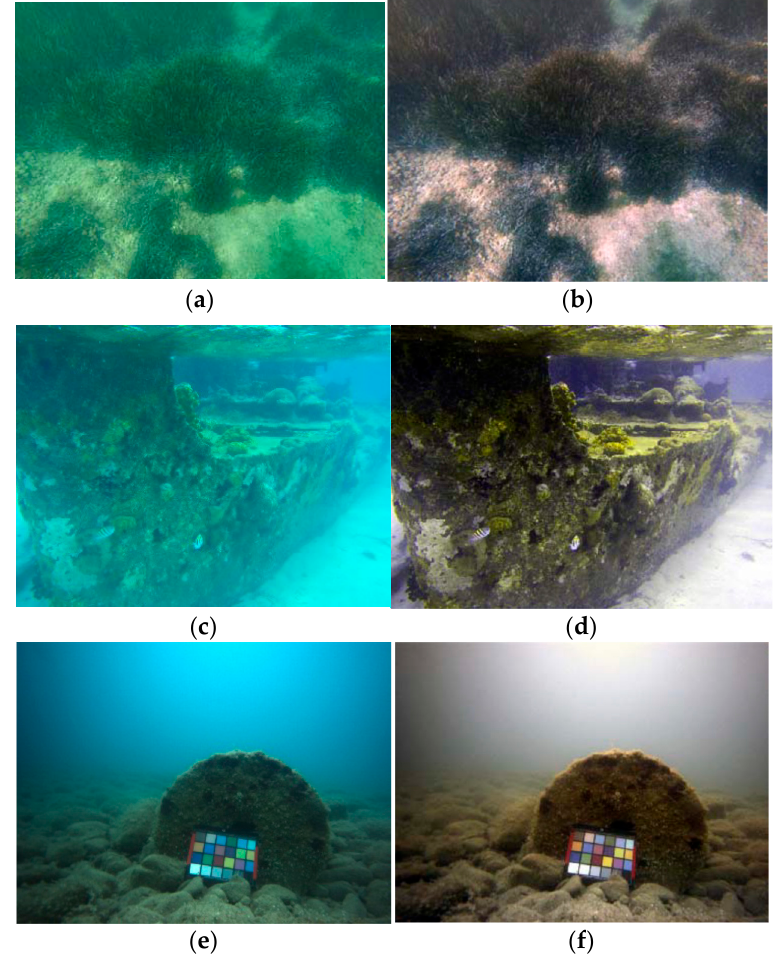
Figure 2. Three real cases of non-uniformly illuminated images processed with the proposed method of Bianco and Neumann. ( a , c , e ) are the uncorrected images and ( b , d , f ) are the results after the correction. Images from [27].